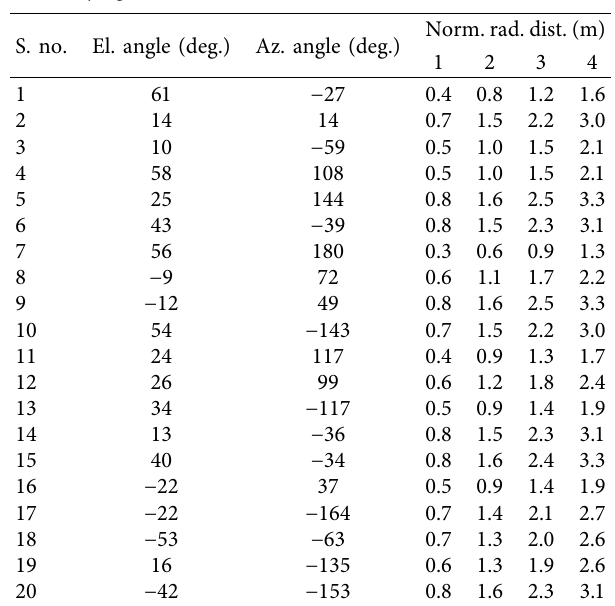
Table 3: Collaborating nodes’ positions 3 dimension confguration with varying cluster radius.